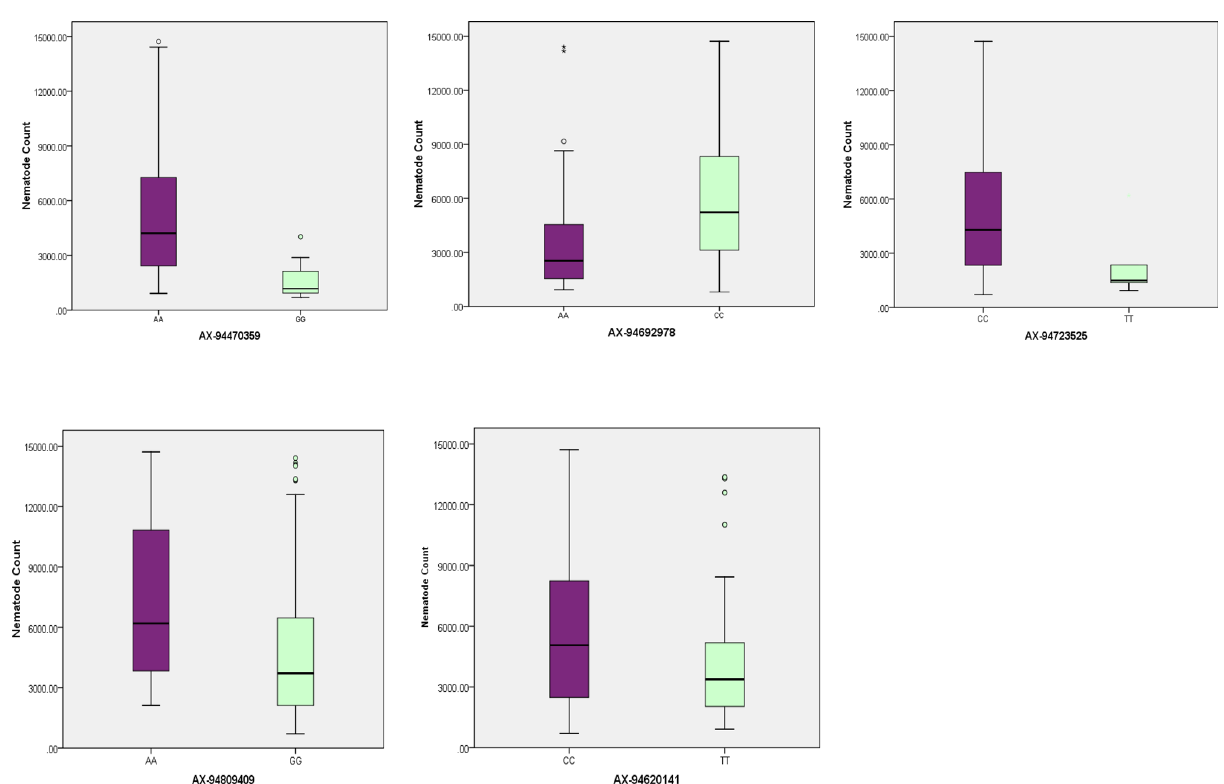
Figure 5. Boxplot showing the allelic effect of five significant MTAs for nematode count, X-axis representing the marker name and alleles, Y-axis depicts nematode count. Alleles which were decreasing or increasing the nematode count considered as favourable and unfavourable alleles,